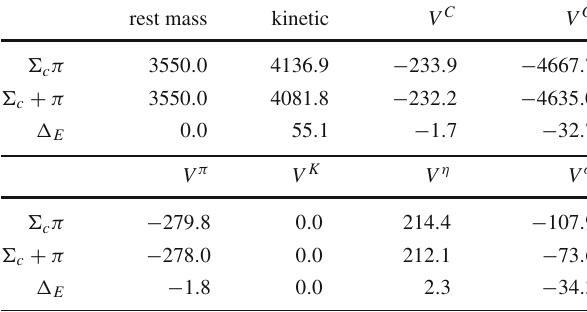
Table 6 The energy components of (cid:2) c π state (unit: MeV)